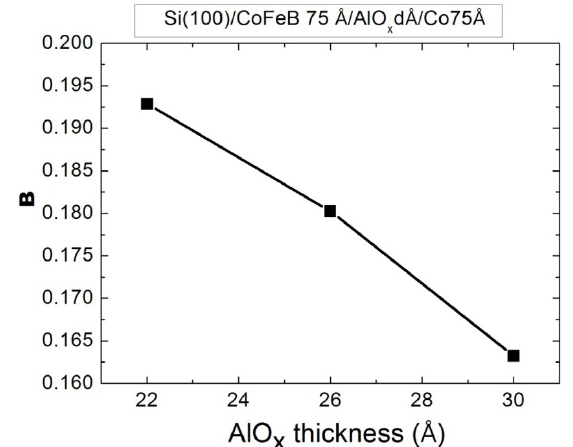
Figure 2. Full width at half maximum (FWHM) ( B ) as a function of thickness ( d ) of AlO